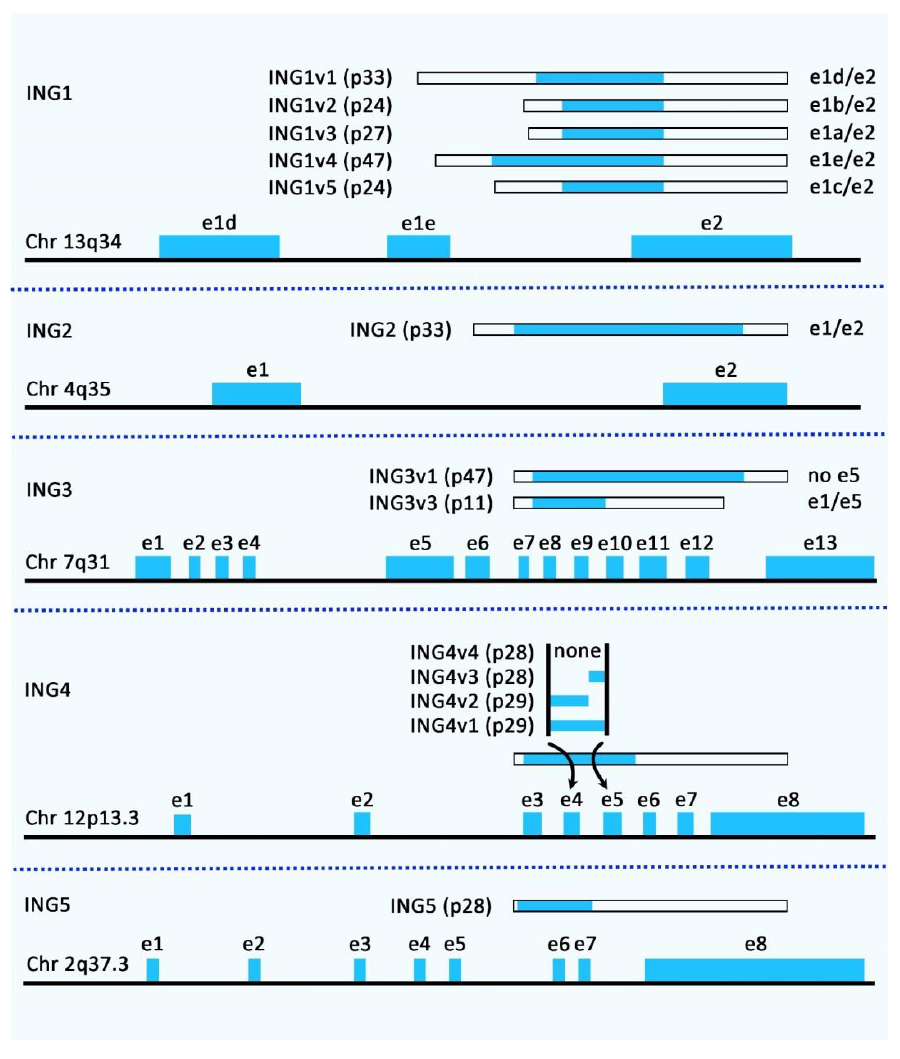
Figure 1. Genomic organization and alternatively spliced variants of human ING family members. Table 1. Summary of information regarding ING family members.